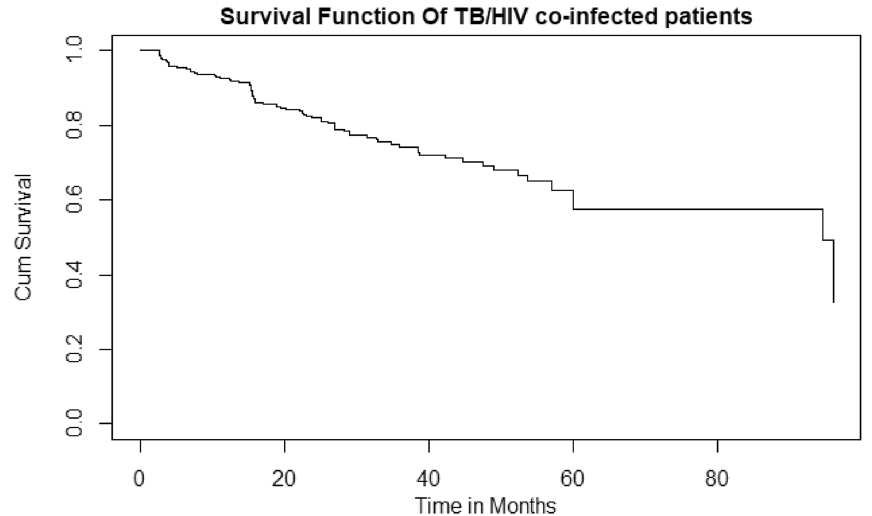
Figure 2. Overall Kaplan–Meier curve of survival proportion of TB/HIV co-infected adults on ART at Mettu Karl Referral Hospital, Ethiopia, 2014–2022 (n = 402).